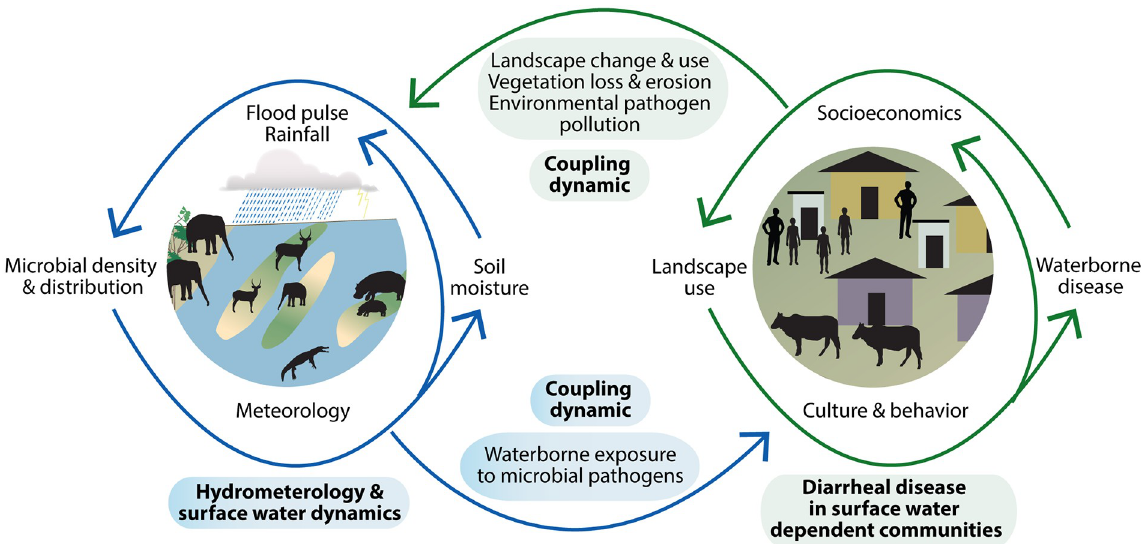
Fig 5. Schematic of linked processes across the aquatic—terrestrial interface in a flood pulse river—floodplain system like the Chobe River in Botswana. Hydrological, geomorphological, sedimentary, and ecological processes influence fecal microbial dynamics, water quality, and human waterborne disease risk in surface-water-dependent populations. These interactions are coupled to sociocultural and economic processes, influencing landscape change and exposure to waterborne disease, feeding back to further environmental degradation and pathogen pollution